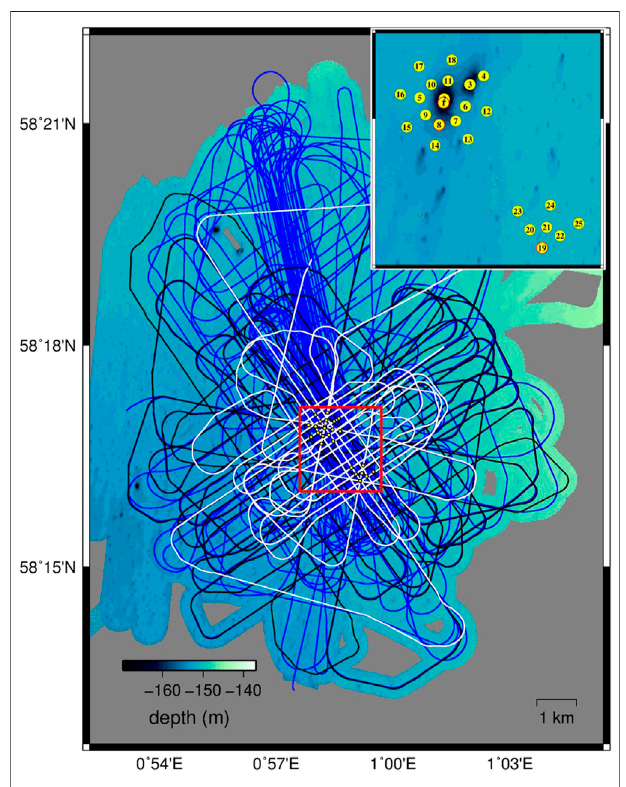
FIGURE 4 | Map of the CHIMNEY seismic experiment. Black, white and blue pro fi les represent GI-gun, Squid 2000 sparker and sub-bottom pro fi ler shots respectively. The 3D seismic volume extends over the entire area displayed. Yellow dots are the OBSs. Red square shows the location of theinset.InsetshowsthelocationoftheOBSsaroundtheScannerpockmark and at the reference site. OBSs 1, 8 and 19 shown in Figures 6 – 8 are surrounded in red.